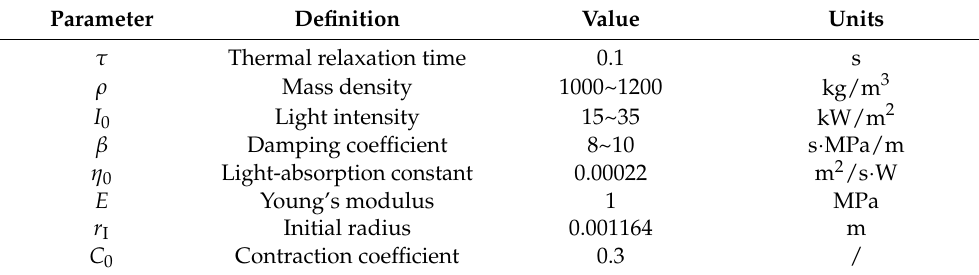
Table 1. Material properties and geometric parameters.